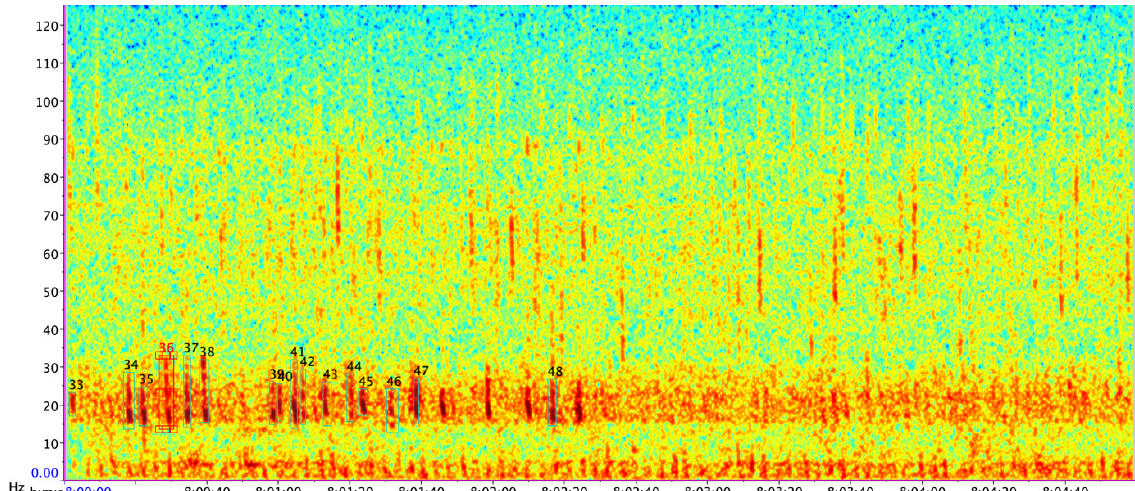
Figure A2. F20P log examples from file 20140215_080000_AWI251-01_AU0231_250Hz for the location Elephant Island.